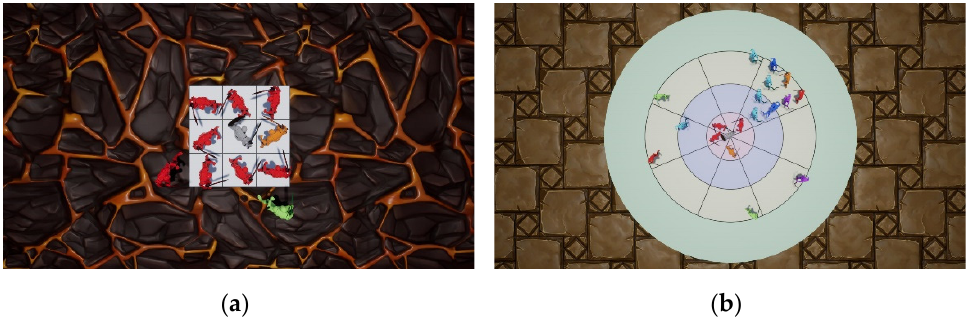
Figure 5. Tests for the number of enemies that can be held. ( a ) BAI; ( b ) IBAI.